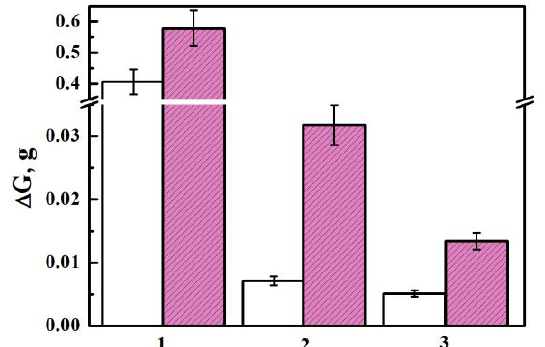
Figure 18. Weight loss Δ G of samples with PEO layers on alloys AK9 (white bars) and AK12 (dark bars) after testing for abrasive wear resistance with a fixed abrasive: 1 — alloys in the initial state; 2 — alloys with PEO layers synthesized in the base electrolyte (3 g/L KOH + 2 g/L Na 2 SiO 3 ); 3 — alloys